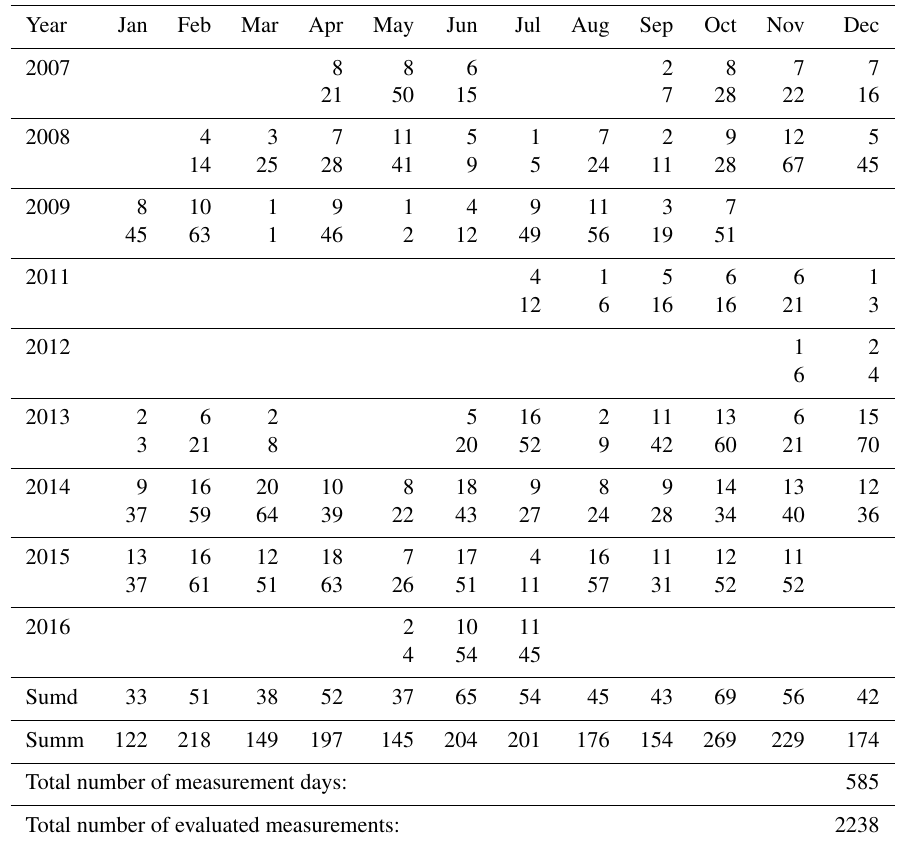
Table 1. Measurement days with the ozone lidar between 2007 and 2016 (first line for a given year) and number of evaluated measurements for a given month (second line); sumd: the number of measurement days; summ: the number of evaluated